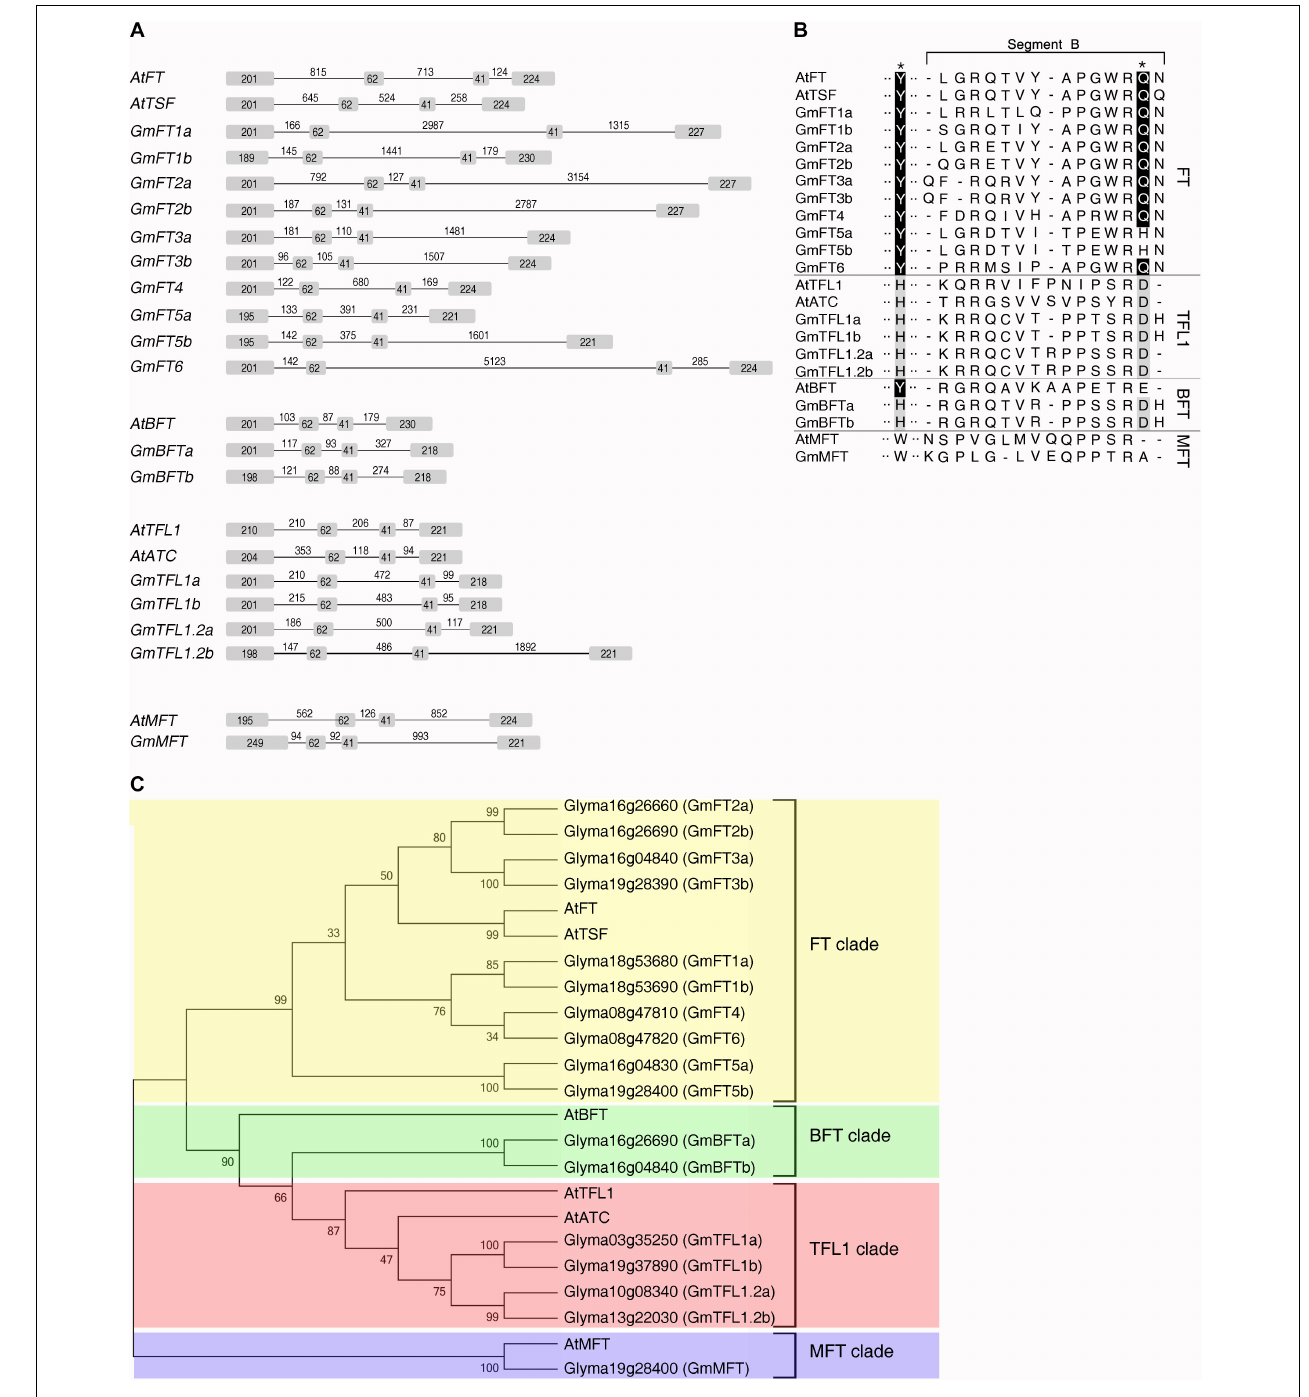
FIGURE 1 | Identification and sequence analysis of soybean PEBP family members. (A) Genomic organization of the soybean and Arabidopsis PEBP family members. Boxes and lines represent exonic and intronic regions, respectively. Numbers indicate the length of exons and introns (base pairs). The gene structures of soybean PEBP family members were determined on the basis of the alignment between the genomic and cDNA sequences. (B) Phylogenetic analysis of Arabidopsis and soybean PEBP family members. The phylogenetic tree was constructed using the Neighbor-Joining method of Mega 4 software program (Tamura et al., 2007) based on the amino acid sequences of the Arabidopsis and soybean PEBP family members. Bootstrap values (1,000 replicates) are indicated at the branches of the tree. (C) Partial amino acid sequence alignment of the 14-amino acid segment B region of soybean and Arabidopsis PEBP family members. Black stars above the upper row indicate the Tyr85(Y)/His88(H) and Gln140(Q)/Asp144(D) residues specifying Arabidopsis FT and TFL1 functions in flowering, respectively.